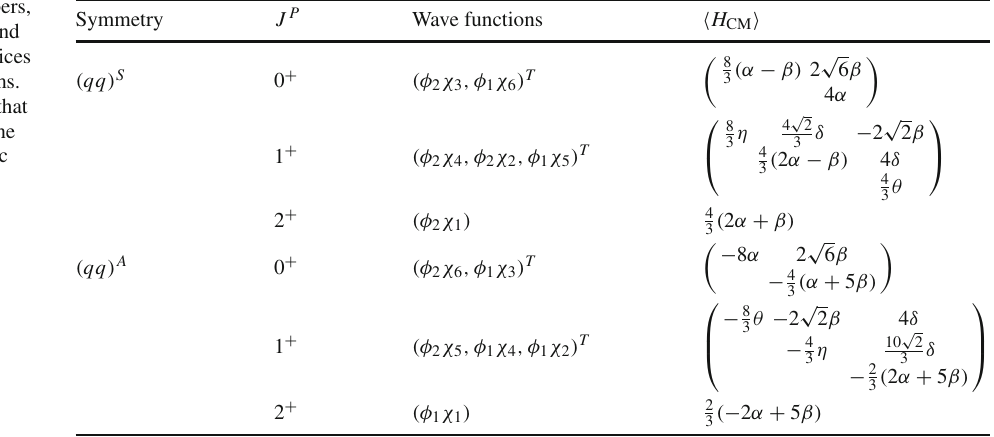
color–spin wave functions, and the corresponding CMI matrices for the nn ¯ c ¯ b and ss ¯ c ¯ b systems. Here, ( qq ) S ( ( qq ) A ) means that the flavor wave function of the two light quarks is symmetric (antisymmetric)